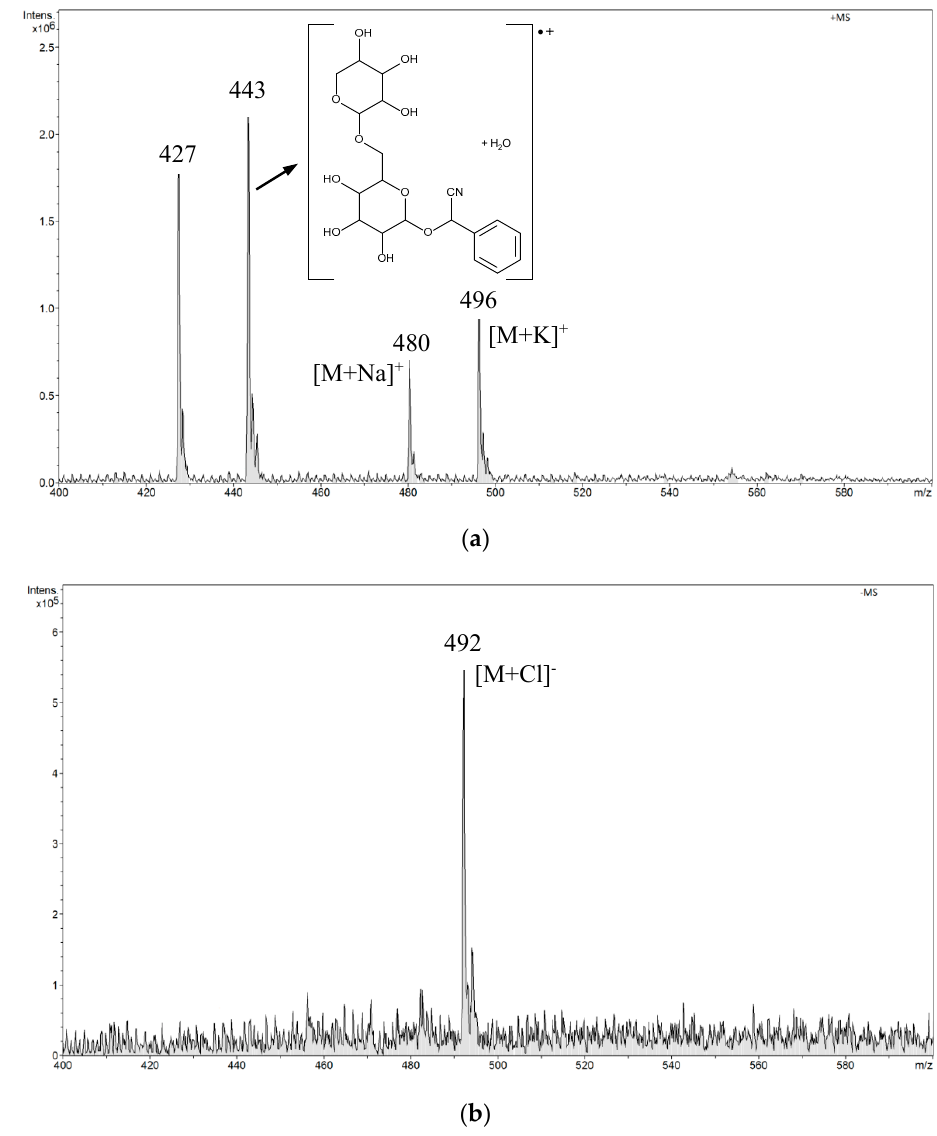
Figure 6. The ESI-MS spectrum of amygdalin performed in a buffer solution of pH 10.0 (boric acid, potassium chloride, and sodium hydroxide): ( a ) positive mode, ( b ) negative mode.